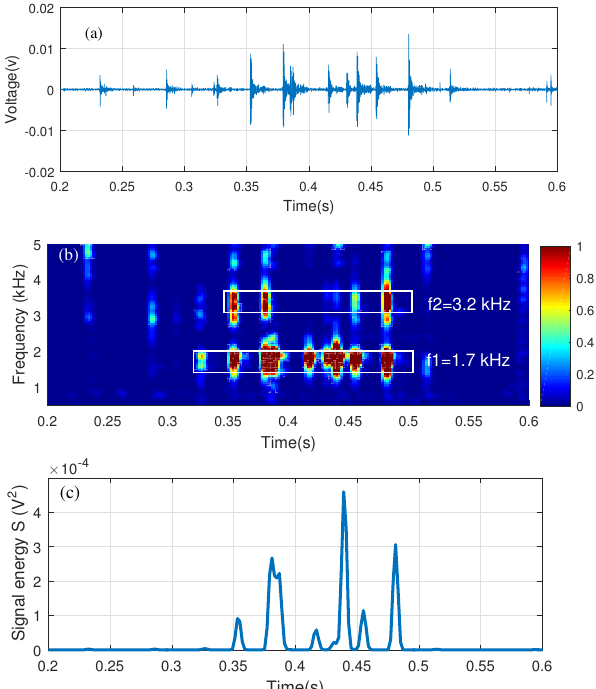
Figure 2. Ball-chain test results: ( a ) time-domain signal; ( b ) STFT spectrogram with normalized amplitude; ( c ) signal